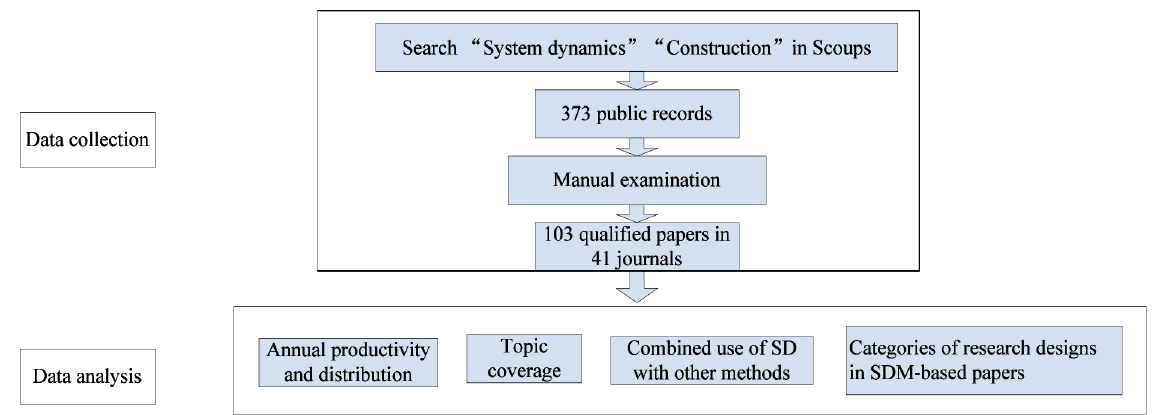
Figure 1. The research process